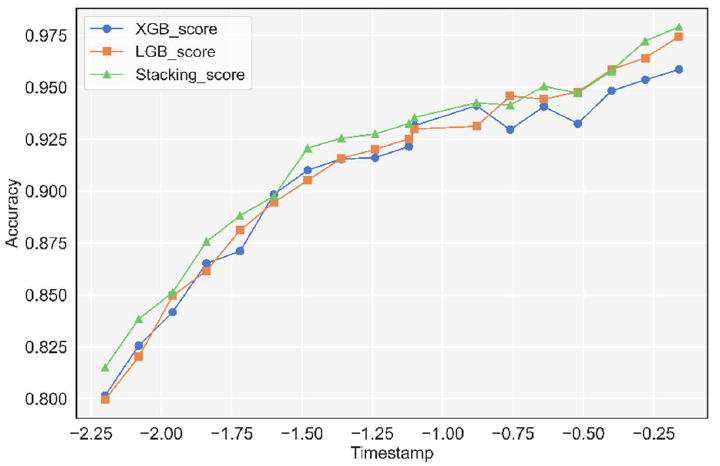
Figure 16. Comparison of accuracy of lane-changing intention recognition at different times.